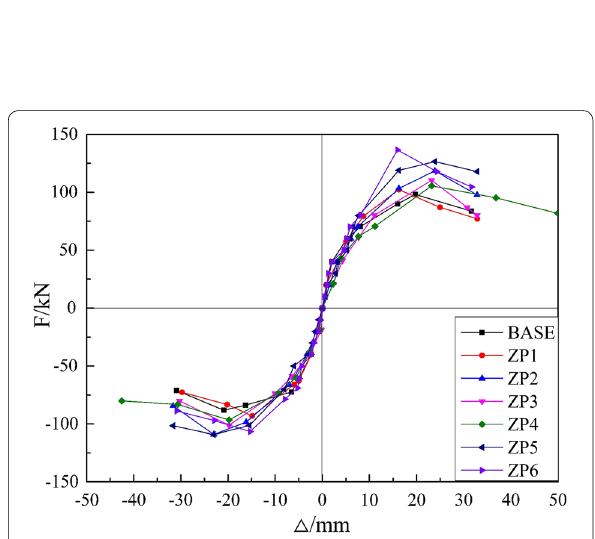
Fig. 8 Load–displacement skeleton curve of the